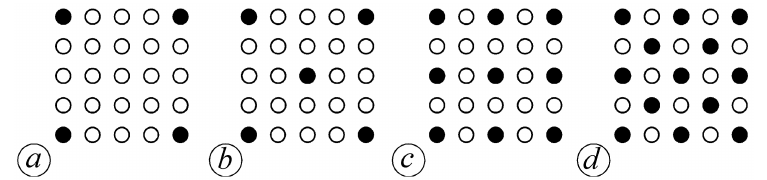
Figure 3. Plants distribution for the four tested configurations: ( a ) plants density n p = 43.75 plant/m 2 ; ( b ) plants density n p = 84.5 plant/m 2 ; ( c ) plants density n p = 156.25 plant/m 2 ; and ( d ) plants density n p = 312.5 plant/m 2 .